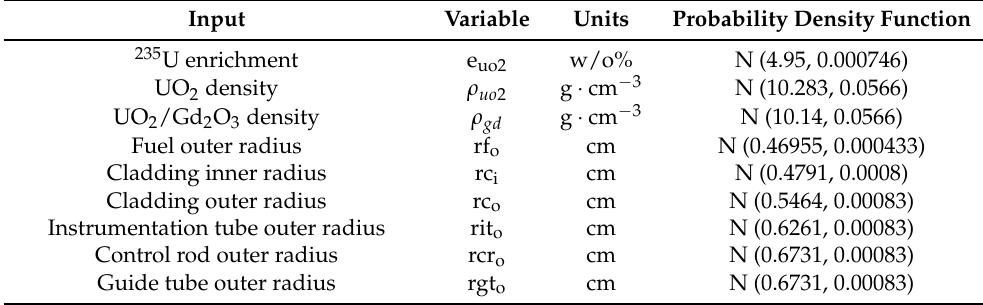
Table 3. Manufacturing parameters input uncertainty quantification with N = Normal (Mean, Standard Deviation) determined based on LWR-UAM Phase II [37] and Phase III [24] specifications and